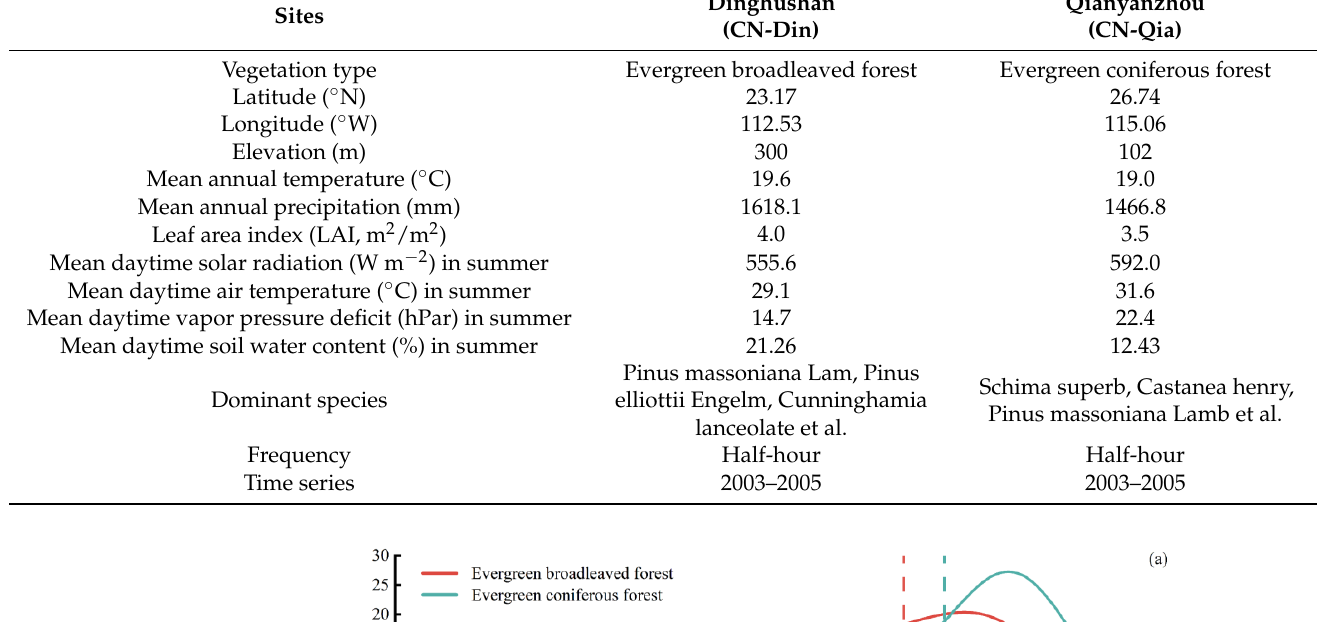
Table 1. Description of site characteristics.